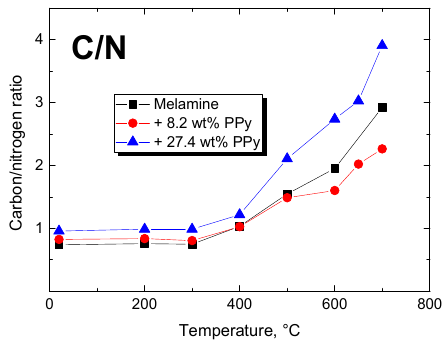
Figure 6. The dependence of carbon-to-nitrogen atomic ratio on the carbonization temperature.